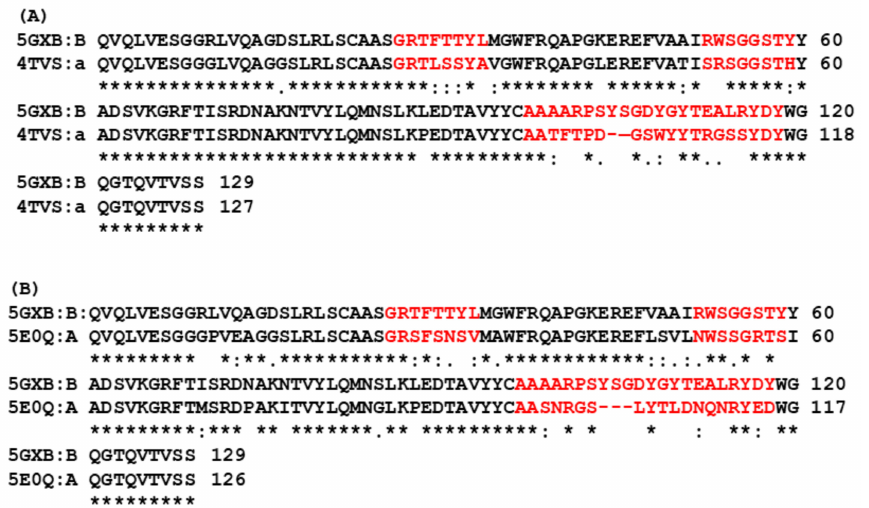
Figure A4. Sequence alignment of V H H binding to LacY (PDB ID 5GXB:B, 129 aa) with its templates. ( A ) Alignment with template PDB ID 4TVS:A (127aa) in bestSeqIdTemp scenario, ( B ) Alignment with template PDB ID 5E0Q:A (126 aa) in bestStructTemp . The highlighted regions in red in each alignment are CDRs separating the FRs. The “:” under aligned residues indicate strong similarity in amino acid conservation, “*” indicates identical residues and ‘.’ indicates weak conservation.